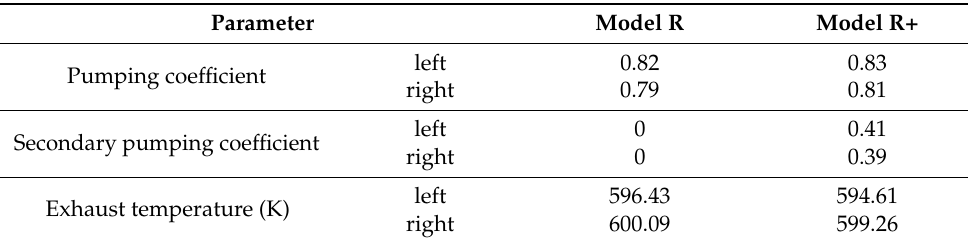
Table 3. Performance parameters of the mixing duct.